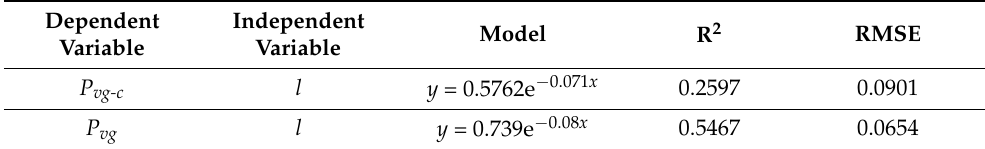
Table 4. Statistical models of P vg and P vg-c estimation using the LAI.